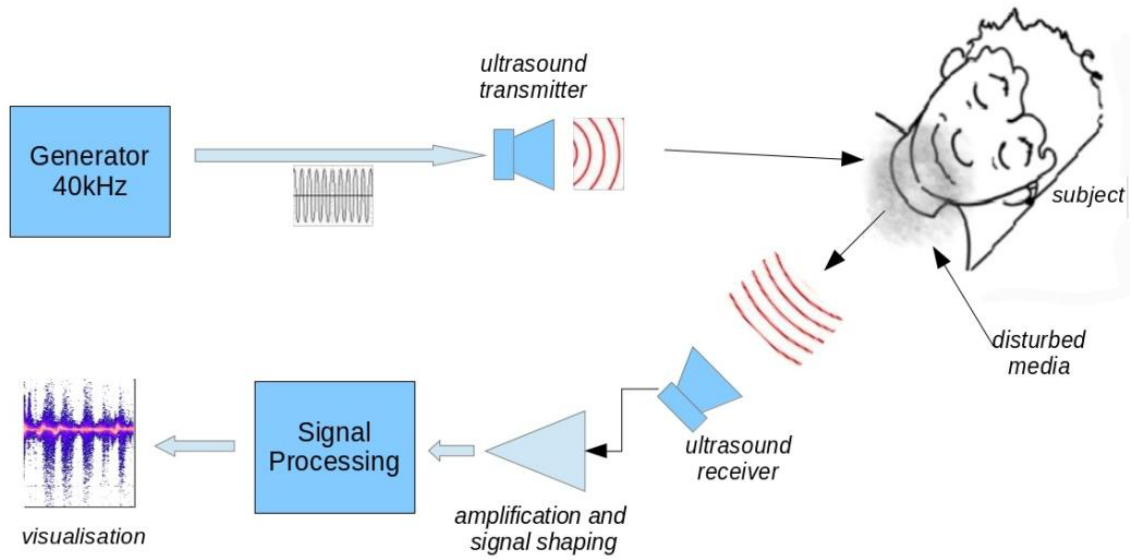
Figure 1. Block diagram of the device. The optimum distances and angles between the transmitter/receiver and the subject depend on the angle of the sensors relative to the head, the level of ultrasound source and the characteristics of the receiving